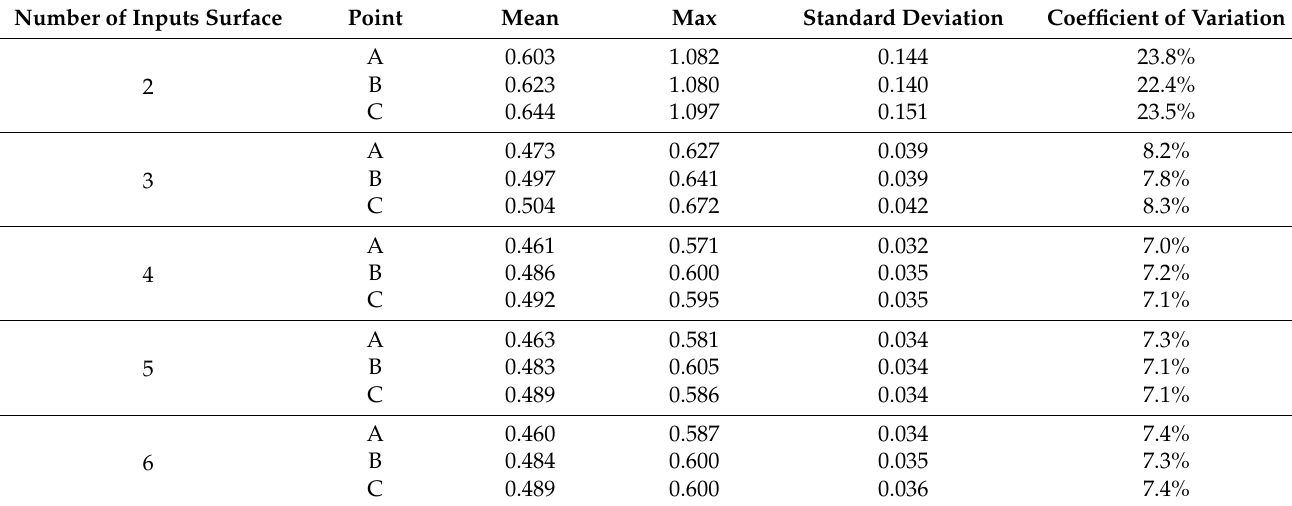
Table 4. Summary of the expanded uncertainty of 95% confidence